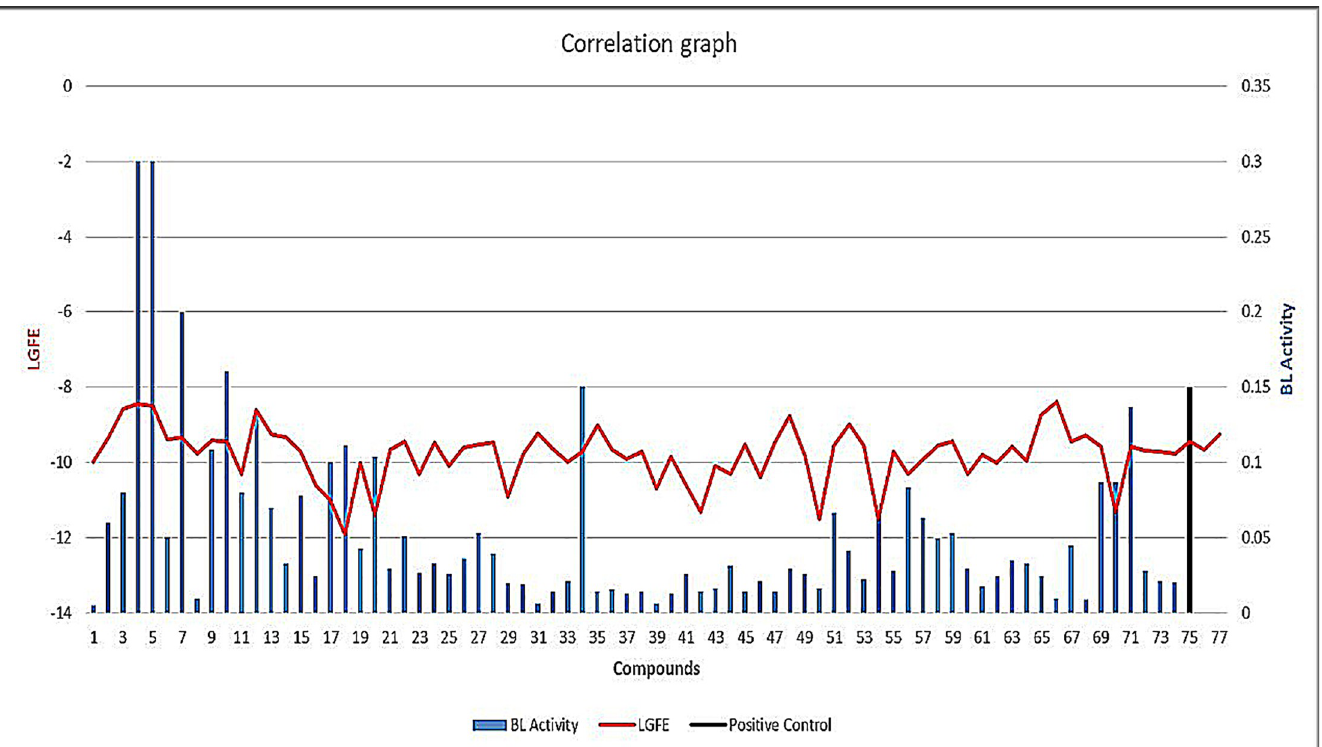
Fig 5. BL-activity and LGFE scores of identified lead compounds. Blue bars showing BL activity with red color indicating LGFE along with positive control in black.